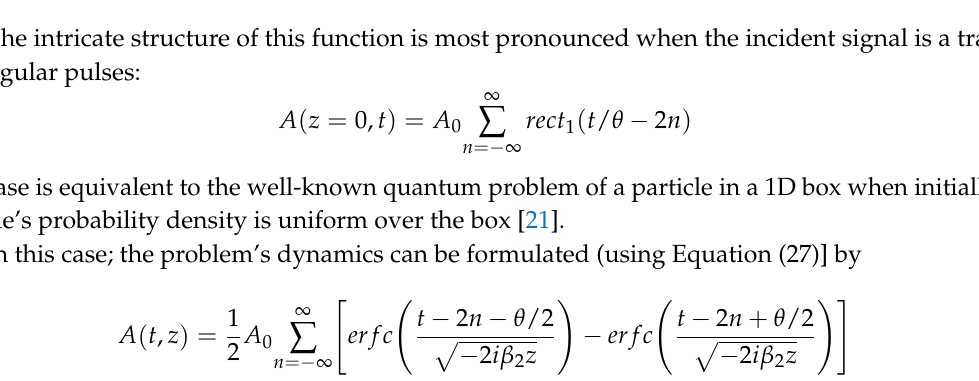
2 ) of the pulse presented by Equation   2 , ztA ) of the pulse presented by Equation (27). Figure 7. Same as Figure 2, but for the intensity ( | A ( t , z ) |